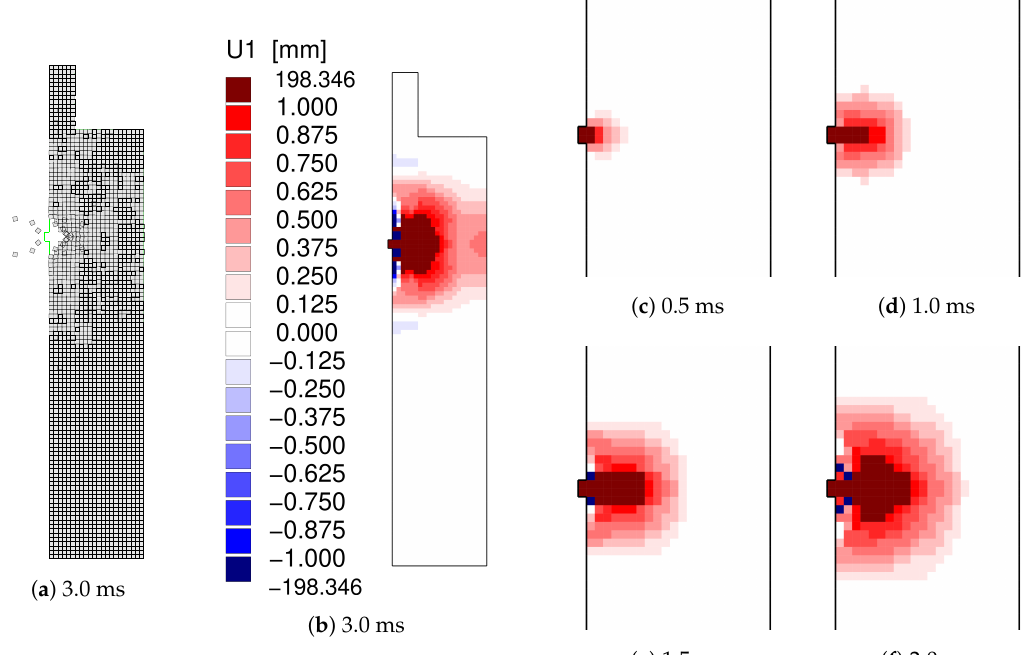
Figure 12. Deformed shape and maps of the displacements in the horizontal direction and zoom on the impact point at different instants of